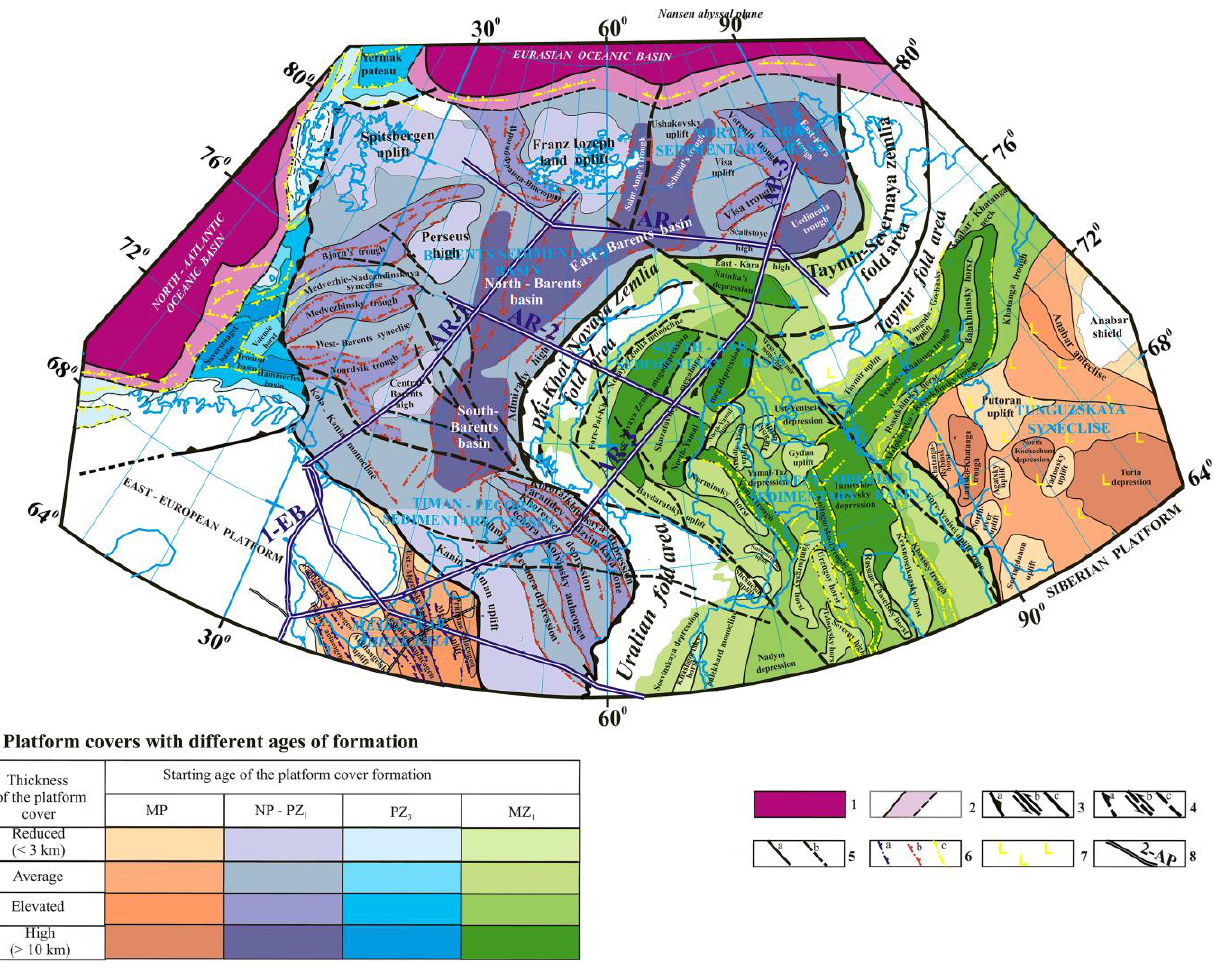
Figure 4. Structural scheme of the platform cover of the Eurasian sector of the Arctic [7]: 1—the oceanic type crust; 2—the continental slope crust; 3—the main faults of the structures of the 1st rank (a—thrusts, b—displacements, c—unknown type); 4—the main faults of the structures of the 2nd grade (a—thrusts, b—displacements, c—unknown type); 5—other fracture defections (a—traced by a number of geophysical data, b—traced by one source); 6—riftogenic structures (a—Riphean, b—Paleozoic, c—Mesozoic); 7—Siberian traps; 8—basic geophysical profiles.